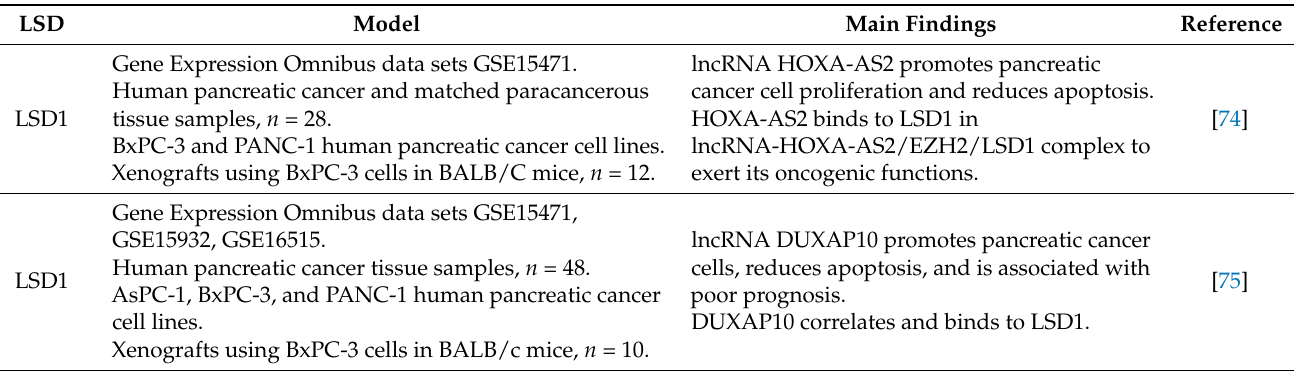
Figure 3. LSD1 and LSD2 expression and its correlation with pancreatic cancer fate. The green colour represents upregulation of each specific molecule, which all together leads to increased pancreatic cancer cell proliferation and decreased apoptosis. Table 3. Recent studies on LSD1/2 in pancreatic